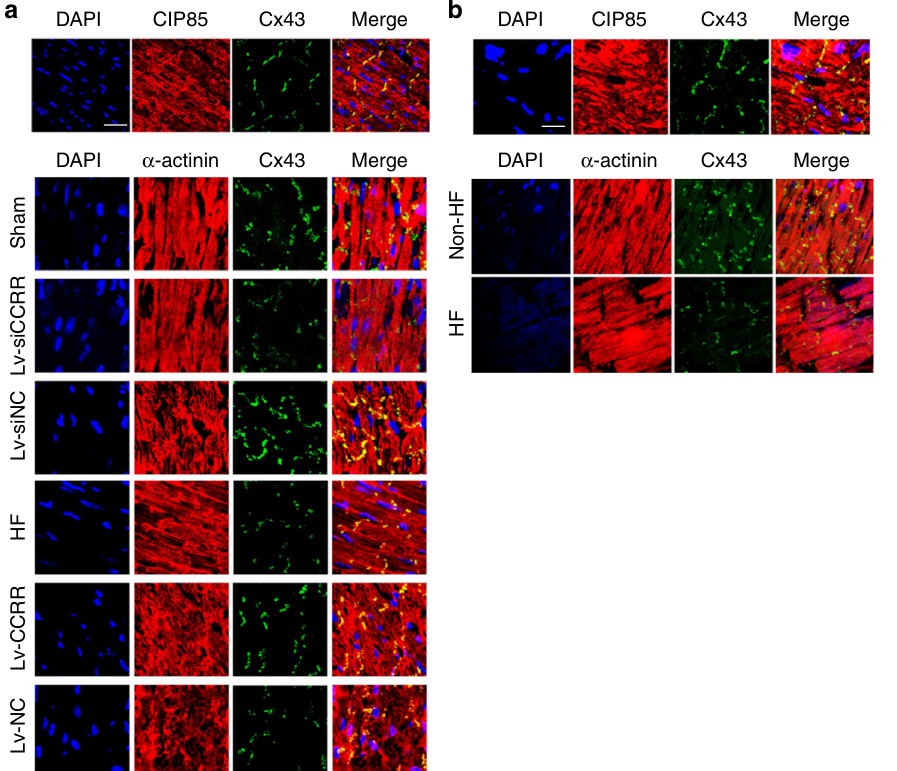
Fig. 5 Effects of CCRR on the gap junction distribution of Cx43 and CIP85. a Immunostaining of cardiac slices showing the co-localization (yellow) of CIP85 (red) and Cx43 (green) proteins at the intercalated discs in healthy hearts (upper panel), and the effects of CCRR on the gap junction distribution of these proteins (600× magni fi cation, lower panel). Knockdown of endogenous CCRR by Lv-siCCRR drastically diminished the presence of Cx43 (stained in green) in the intercalated discs in healthy mouse hearts, resembling the changes caused by HF. In contrast, CCRR overexpression by Lv-CCRR normalized the HF- induced expression repression of Cx43. DAPI (blue) was used to stain nuclei and α -actinin (red) to identify the cell contour. Similar results were observed in another three separate experiments. b Immunostaining of cardiac slices showing the co-localization of CIP85 (stained in red) and Cx43 (green) proteins at the intercalated discs in healthy control subjects (600× magni fi cation). Cx43 in the intercalated discs in HF patient signi fi cantly diminished compared with healthy control subjects. DAPI (blue) was used to stain nuclei and α -actinin (red) to identify the cell contour. Similar results were observed in